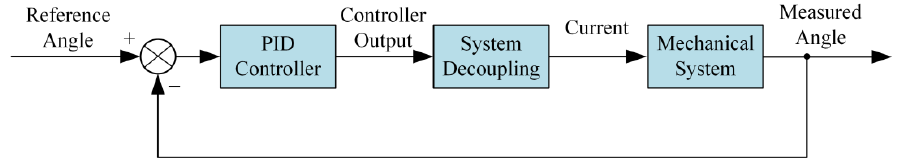
Figure 9. Overall architecture of the control system.